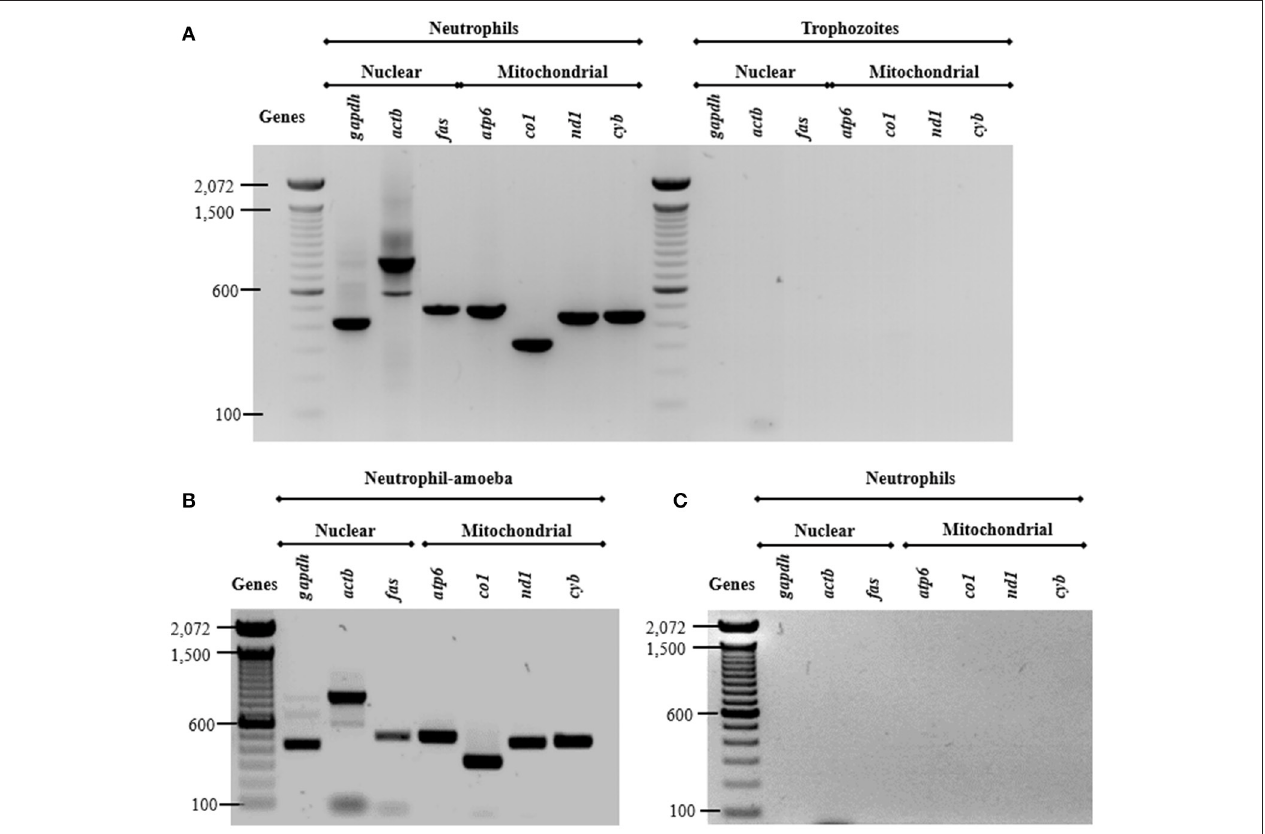
FIGURE 6 | Both nuclear and mitochondrial DNA composes NETs induced by E. histolytica trophozoites. (A) DNA from neutrophils and trophozoites were extracted and PCR was performed to amplify three nuclear ( gapdh, actb, and fas ) and four mitochondrial ( atp6, co1, nd1, and cyb ) genes. Supernatant from (B) neutrophil (1 × 10 6 )-trophozoites (5 × 10 4 ) co-cultures or (C) from neutrophils without any stimulus were directly used as template for PCR reactions to amplify the nuclear and mitochondrial genes. PCR amplicons were run 1% agarose gels and stained with ethidium bromide for